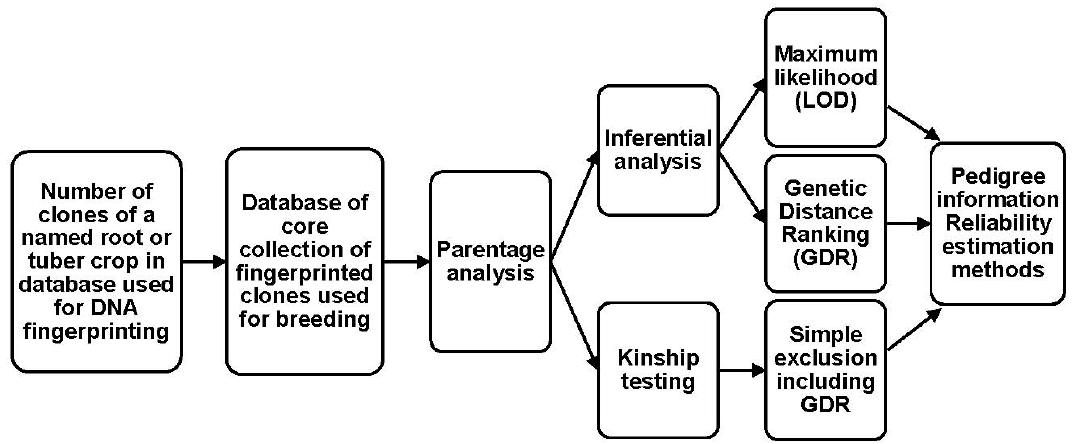
Figure 3. A flowchart of the experimental procedure of parentage analysis of a typical root or tuber crop. LOD, logarithm of